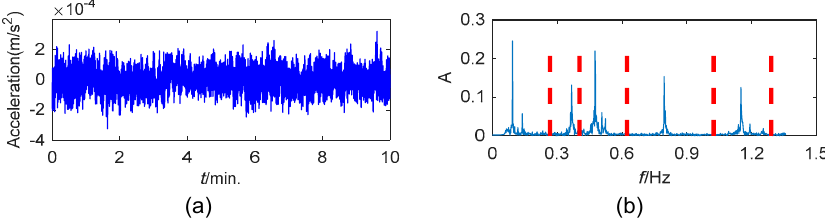
Figure 8. ( a ) The time history of the analyzed acceleration data from Canton Tower; ( b ) the detected boundaries in the Fourier spectrum.